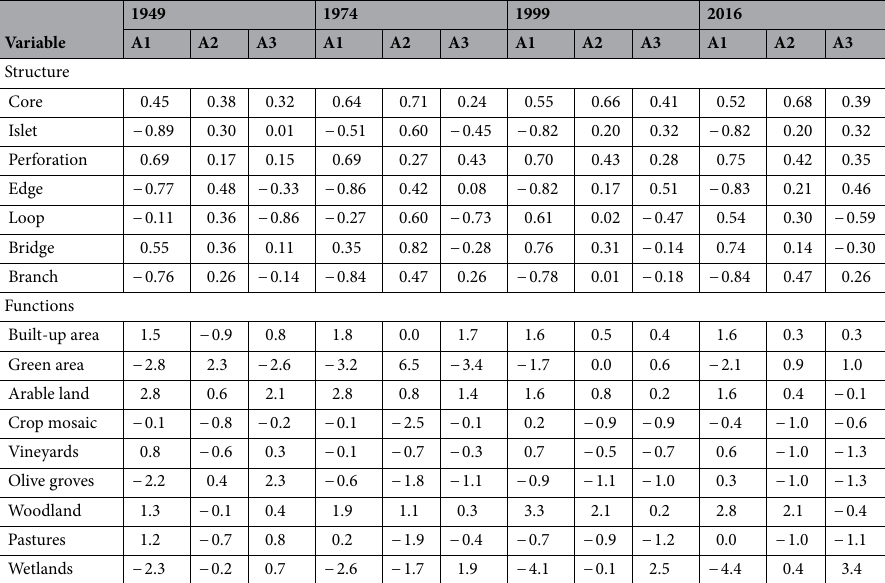
Table 4. Results of a dynamic Multi-way Factor Analysis (MFA) resuming changes over time in structural and functional (landscape) indicators over the first three Axes (A1–A3) of the factorial plane in metropolitan Rome, by